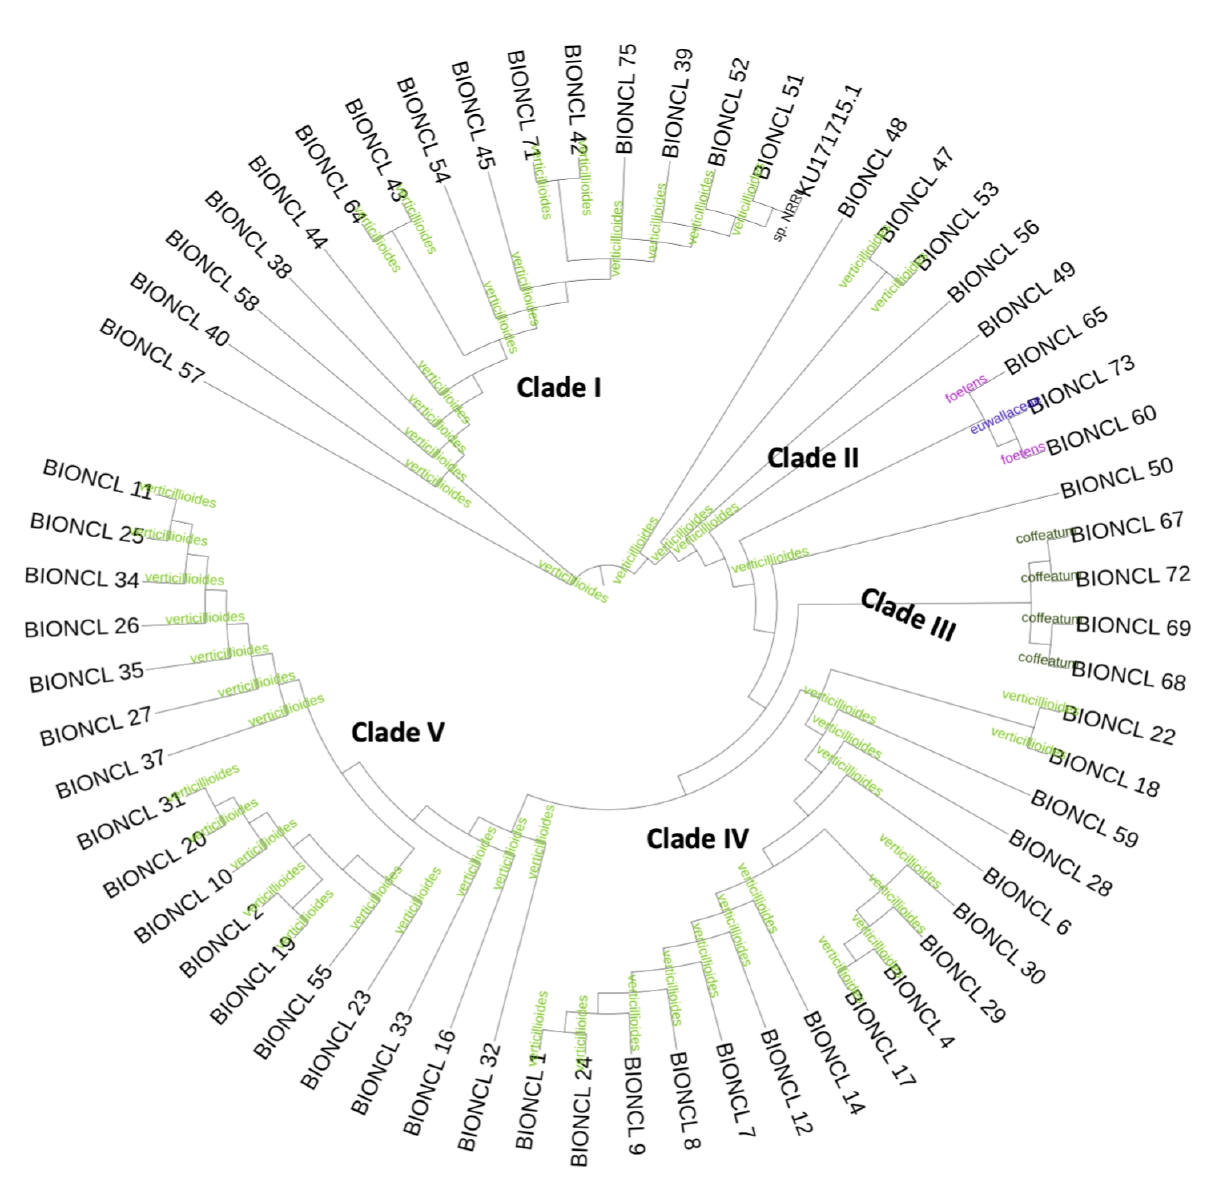
Figure 1 – Phylogenetic analysis of Fusarium strains based on TEF1-α gene